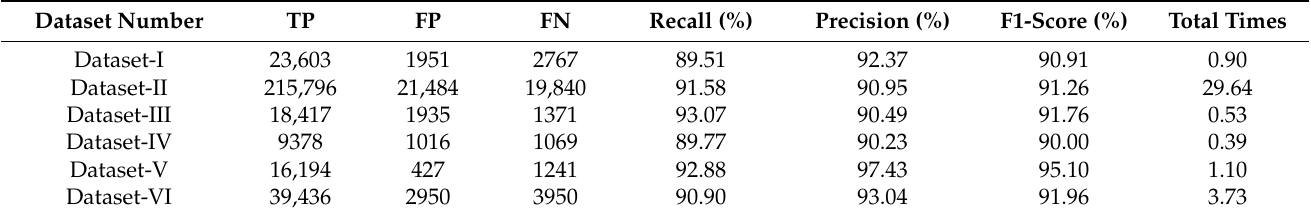
Figure 13. Telegraph pole extraction process: ( a ) The extraction process for telegraph pole I. ( b ) The extraction process for telegraph pole II. ( c ) The extraction process for telegraph pole III. ( d ) The extraction process for telegraph pole IV. Table 5. The telegraph pole extraction